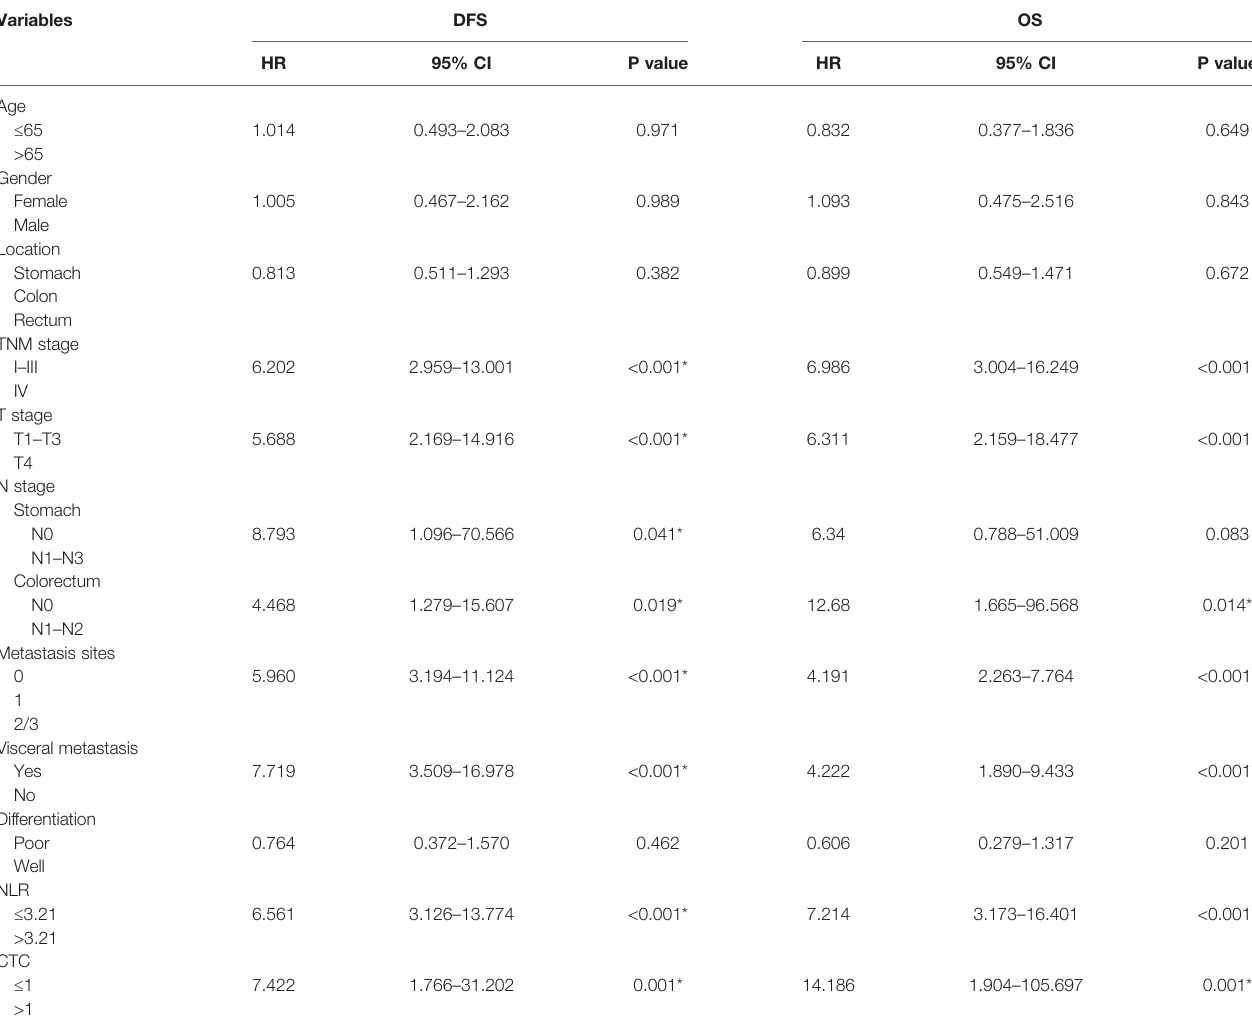
TABLE 3 | Univariate analysis of clinicopathological characteristics associated with